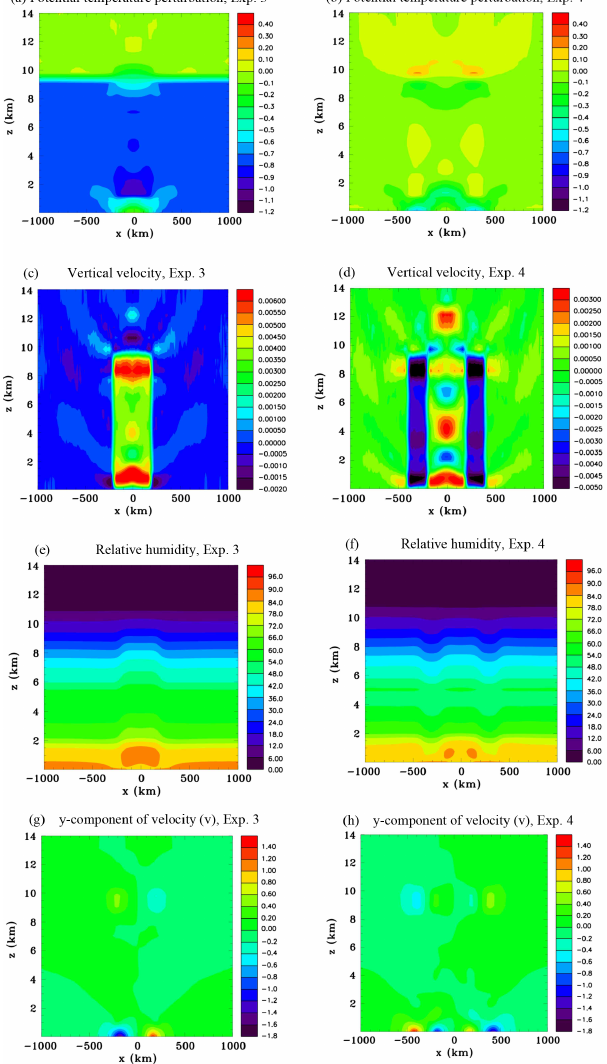
Figure 4. Vertical sections comparing Experiment 3: the uniform cooling case with Experiment 4, the small annulus case, at t = 12h. (a) and (b) potential temperature perturbation (K), (c) and (d) ver- tical velocity (ms − 1 ), (e) and (f) relative humidity, and (g) and (h) y -component of velocity, v (ms − 1 ), for Experiments 3 and 4, re-